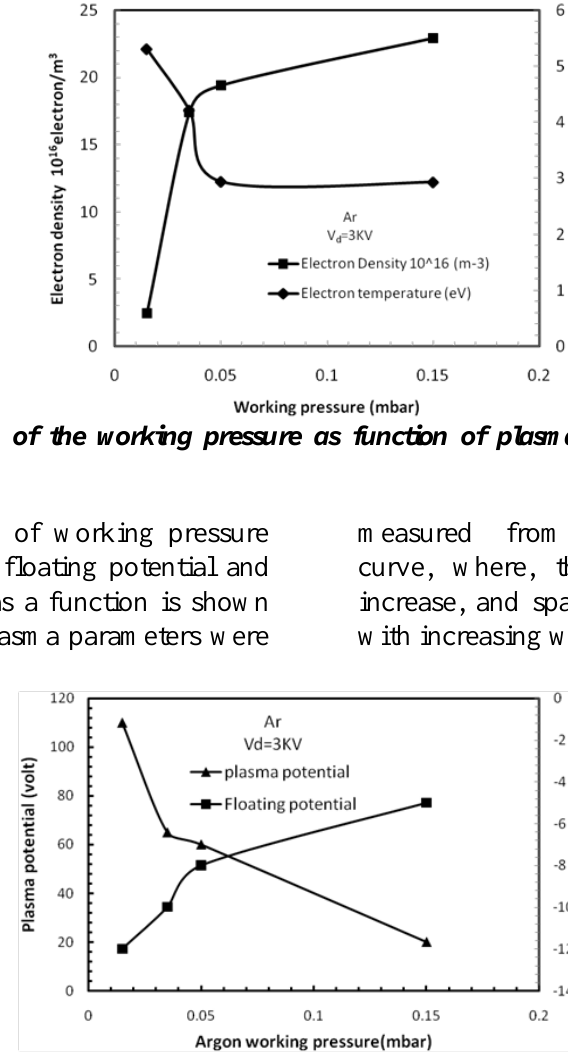
Fig. 7: Working pressure as a function of Floating potential, and space